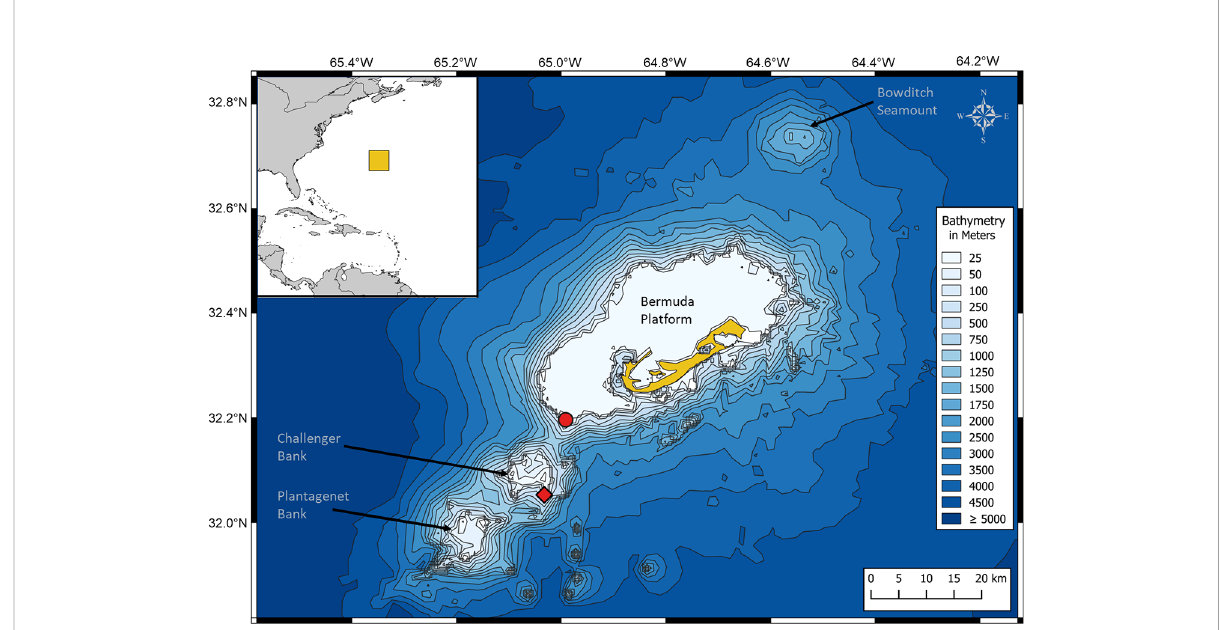
FIGURE 1 Map of the study area, showing Bermuda (in yellow) and the three seamounts Bowditch Seamount, Challenger Bank and Plantagenet Bank. The three hydrophones were deployed on Challenger Bank (red rhombus) and Sally Tucker (red circle), which are 13 km apart. The map was created in QGIS 3.2 software (QGIS Development Team, 2016) using the coordinate reference system WGS 84, EPSG: 4326 and a world (source: Natural Earth) and bathymetry map (source: Open Digital Elevation Model,